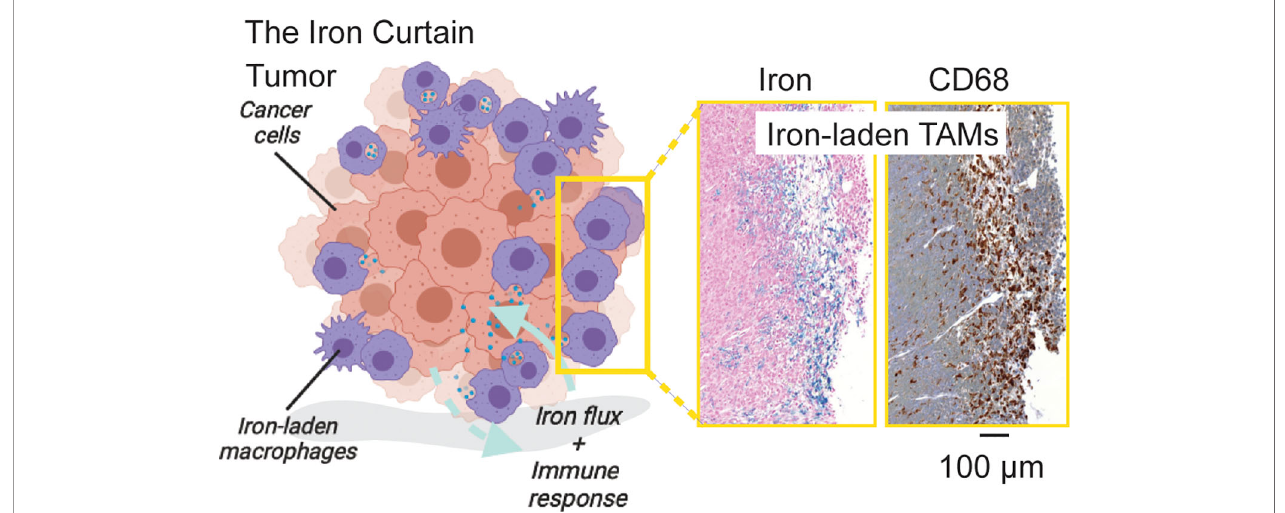
FIGURE 2 | The Iron Curtain. Iron-laden macrophages occupy a unique cellular niche in the tumor where they act as an interfacial boundary mediating systemic and microenvironment metabolic fl ux and immune response. Prussian Blue iron histochemistry which is speci fi c for ferric iron deposits from endogenous hemosiderin (shown here) or iron nanoparticle contrast agent (not shown) in such macrophages beside pan-macrophage CD68 immunohistochemical staining reveals a distinct spatial pathology of such iron-laden macrophages suggestive of an “ Iron Curtain ” where colonies of TAMs exhibiting similar iron accumulation phenotypes form physical borders in the